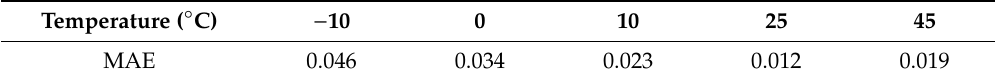
Table 6. Mean absolute errors (MAE) of terminal voltage (V).